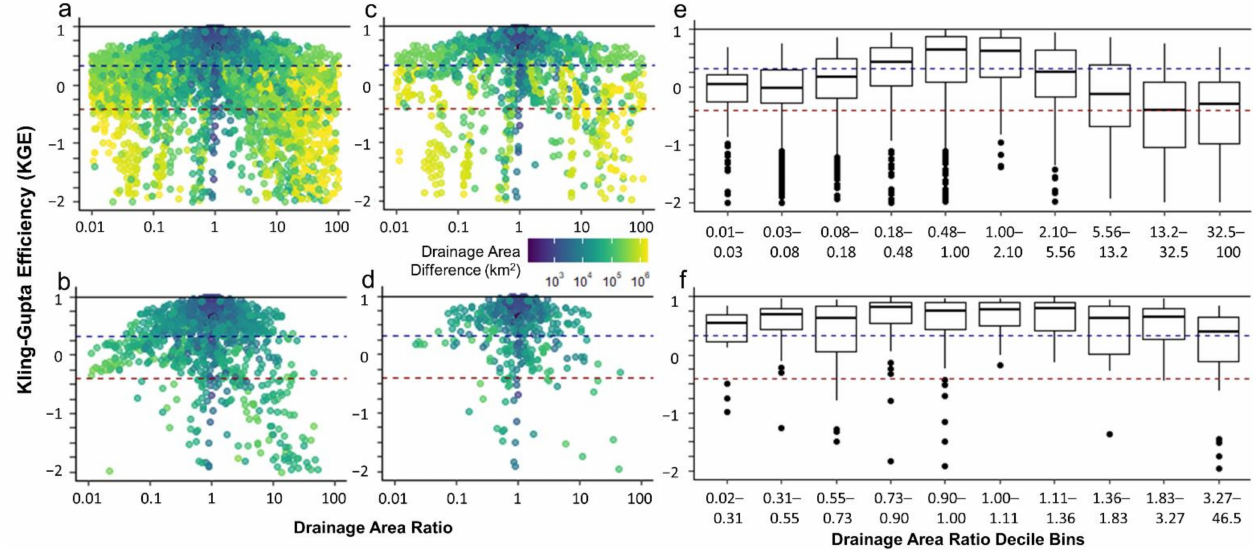
Figure 4. ( a – d ) Kling Gupta Efficiency (KGE) values between the 354 gauges vs. drainage area ratio. Points are colored by the difference in drainage area (km 2 ) between the compared gauges. ( a ) all possible gauge comparison results (4344 pts), ( b ) gauge comparison results with cumulative urban land less than 196 km 2 between gauges (1340 pts), ( c ) gauge comparison results without GROD dams in between gauges (1412 pts) and ( d ) Filtered by comparison results without GROD dams or cumulative urban land area greater than 196 km 2 between gauges (510 pts). ( e , f ) KGE values compared via boxplot with decile bins of drainage area ratio. ( e ) Each boxplot has a tenth (~434) of the total results (4344). ( f ) Each boxplot has a tenth (~51) of the total filtered results (510). For all panels, the black horizontal line at 1 indicates the optimal KGE value, the blue dashed line indicates the study’s defined “good” KGE value of 0.32, and the red dashed line is at KGE = − 0.41, the threshold for the metric where the model improves upon the mean flow benchmark. Results are cut off at KGE = − 2, but 563 comparisons (13%) are below this threshold for panels a and e, 82 (6%) for panel b, 113 (8%) for panel c, and only 16 comparisons (3%) are below the threshold for panels d and